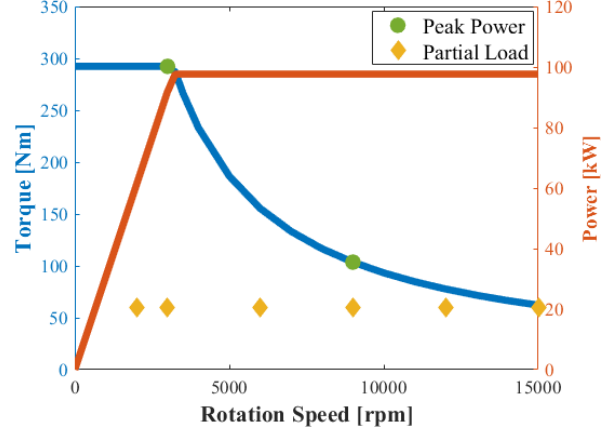
Figure 15. Torque/power-speed curves overlaid with the selected key operating points at peak power and partial load.